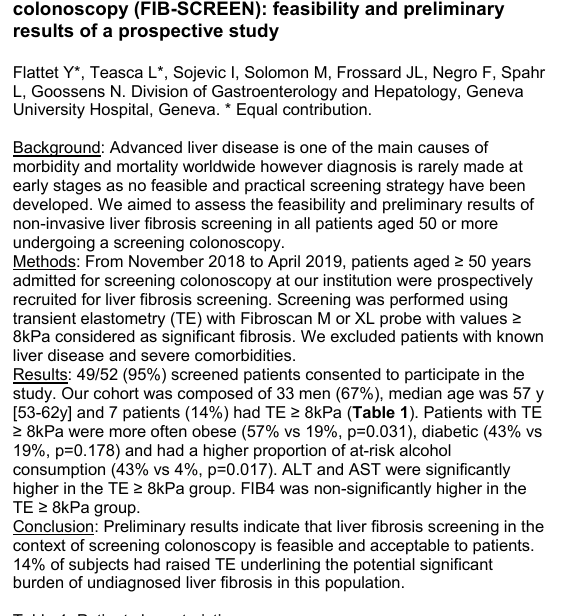
Table 1: Patient characteristics